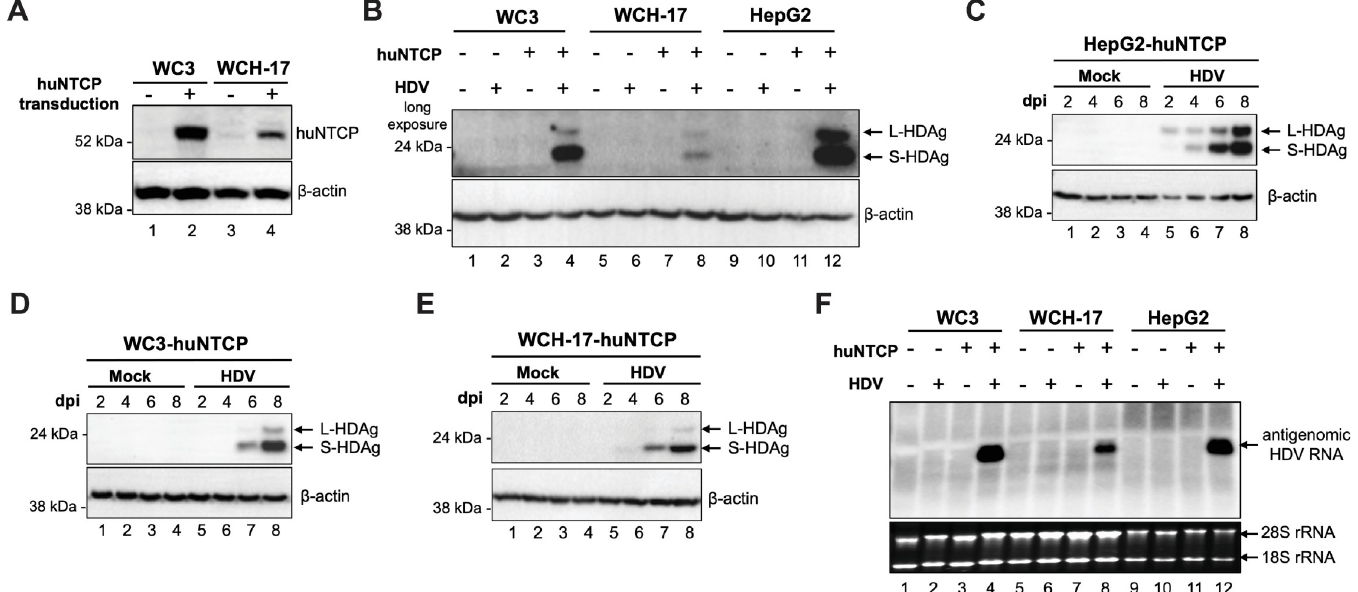
Fig 3. huNTCP expression in woodchuck hepatic cells conferred susceptibility to HDV infection. (A) Western blot analysis of deglycosylated cell lysates from parental and huNTCP-expressing cells for validating huNTCP expression. β -actin was used as the loading control. (B) Western blot analysis of whole cell lysates of parental and huNTCP-expressing cells at 8 days post-infection with HDV (ca. 200 genome equivalent per cell) for detecting HDAg using human HDAg antibody. Whole cell lysates of mock-infected or HDV-infected HepG2-huNTCP (C), WC3-huNTCP (D), and WCH-17-huNTCP (E) cells were harvested at 2-, 4-, 6-, and 8-days post-infection and resolved by SDS-PAGE and immunoblotted with human HDAg antibody. (F) Total RNA from mock- or HDV-infected parental or huNTCP-expressing cells were extracted at 8-days post-infection, and 5 μ g of total RNA was analyzed by Northern blot for HDV antigenomic RNA. L-HDAg, large HDAg; S-HDAg, small HDAg.